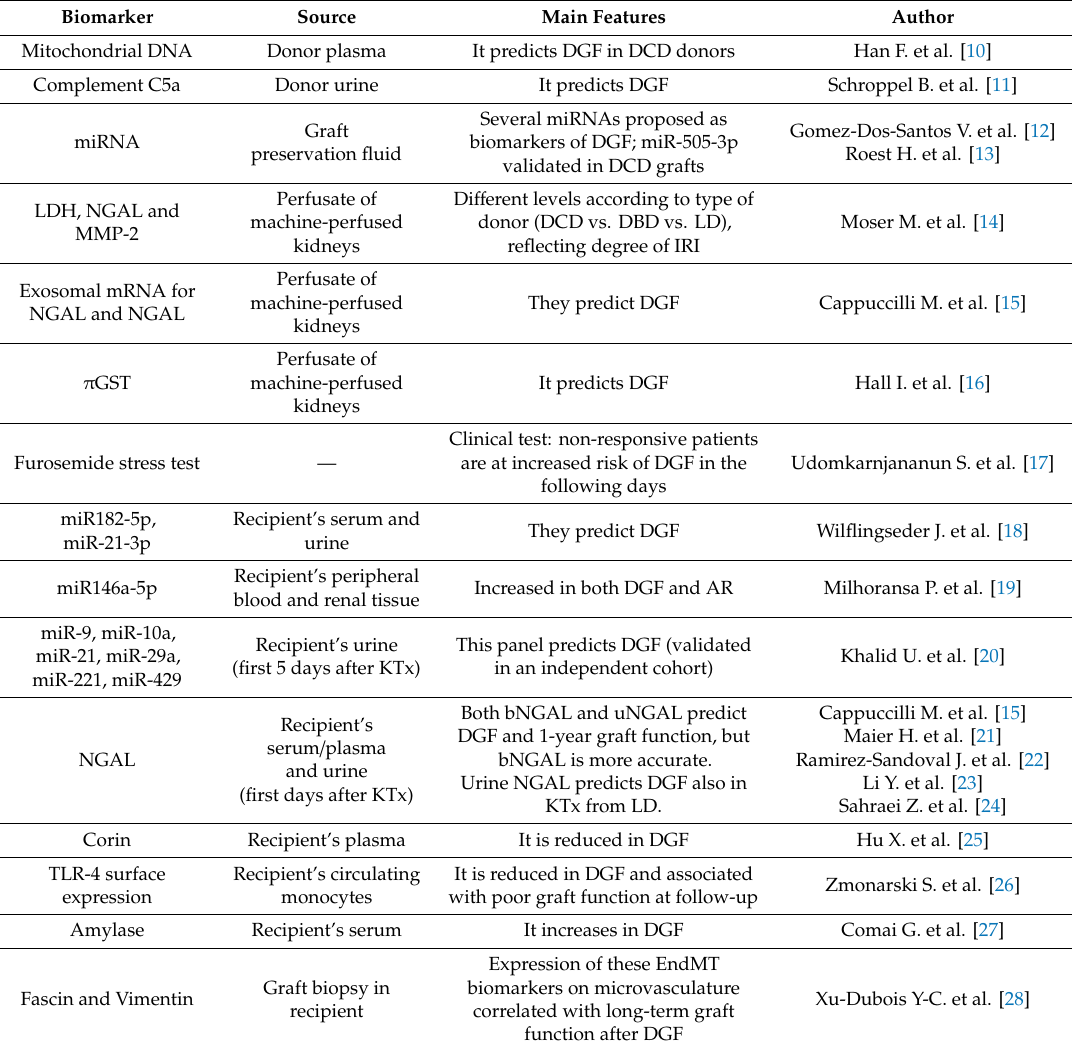
Table 2. Potential biomarkers for